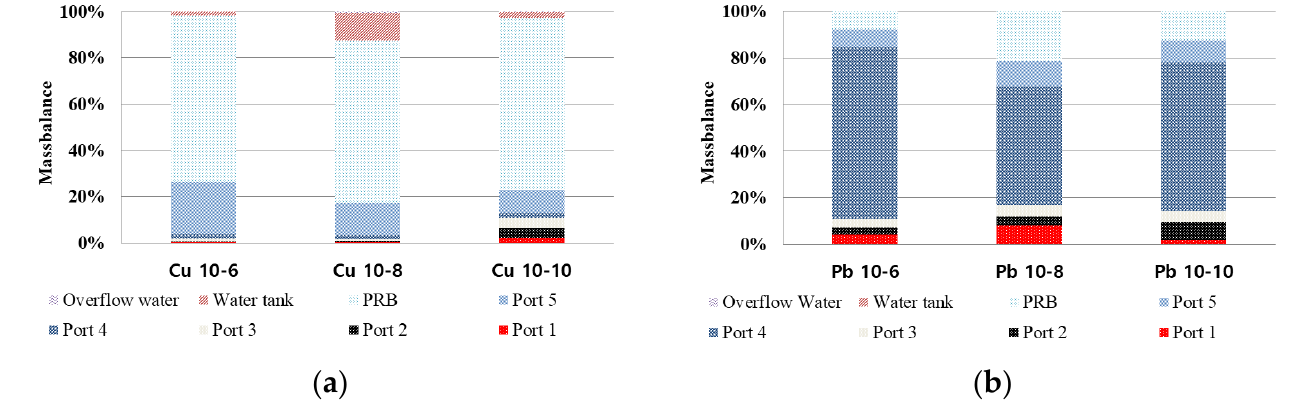
Figure 10. Mass balance: ( a ) copper; ( b ) lead. Table 2. Mass balance and removal rates.